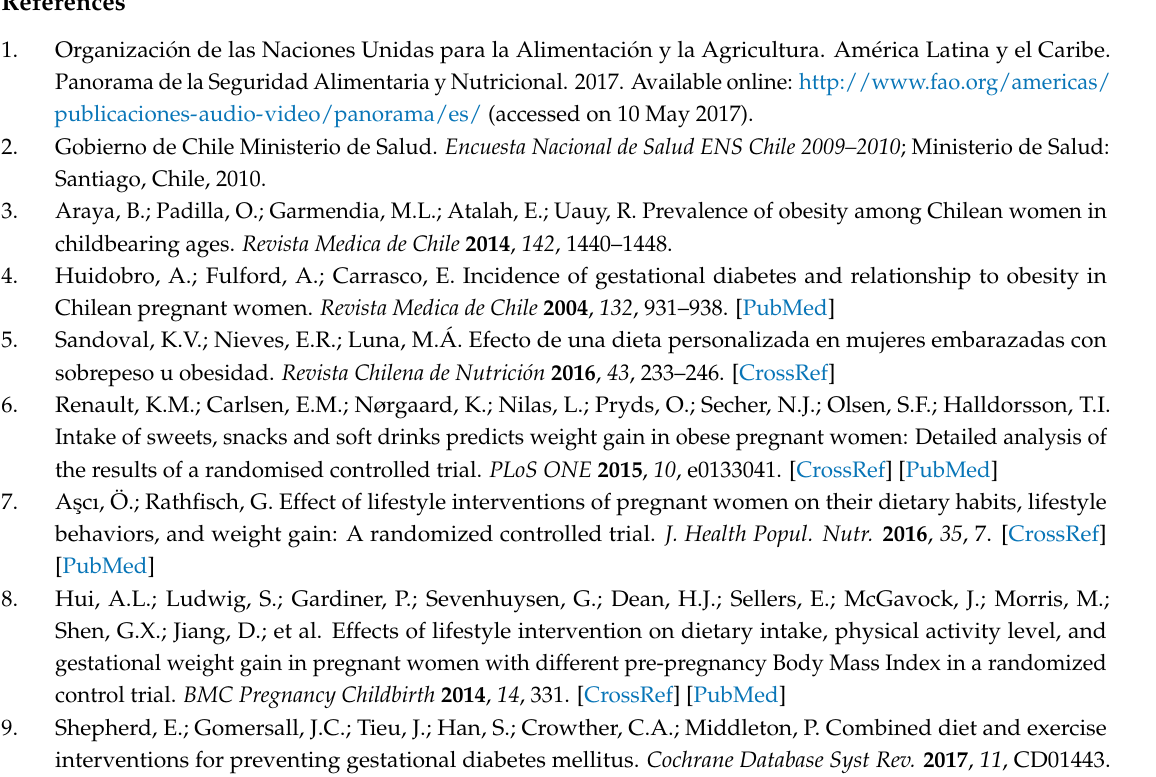
Table S1: Effect of the nutritional intervention on the change of consumption of total sugars and energy. Linear regression